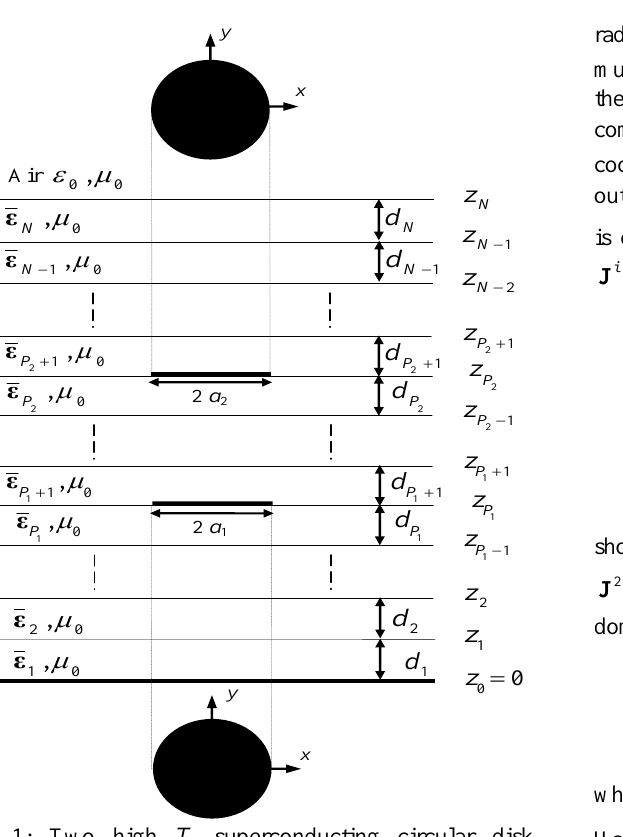
Figure 1: Two high T c superconducting circular disk microstrip antenna in a stacked configuration. the same superconducting material. The radii of the bottom patch of thickness e and the top one of thickness 1